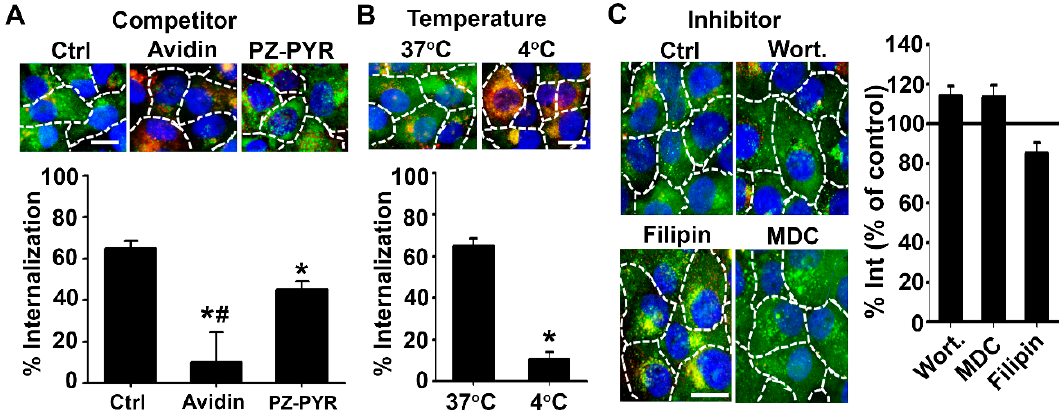
Figure 4. Mechanism of uptake of PZ/protein complexes by cells. Cal27 cells incubated for 2 h with FITC-avidin complexed to PZ-PYR: ( A ) in control (Ctrl) cell medium vs. medium containing avidin or polymer (competitors), ( B ) at 4 °C vs. 37 °C, or ( C ) in control cell medium vs. medium containing inhibitors of macropinocytosis (wortmannin, Wort), caveolar pathway (filipin) or the clathrin pathway (MDC). All cells were then fixed after incubation, surface-bound FITC-avidin was co-stained with a Texas Red biotin-IgG (green + red = yellow), and nuclei were stained with blue DAPI. Dashed lines = cell borders as seen by bright field. Scale bar = 10 µ m. Fluorescent images and their quantification are shown. Data expressed as mean ± SEM. * p < 0.05 relative to the respective control condition. # p < 0.05 relative to PZ-PYR.